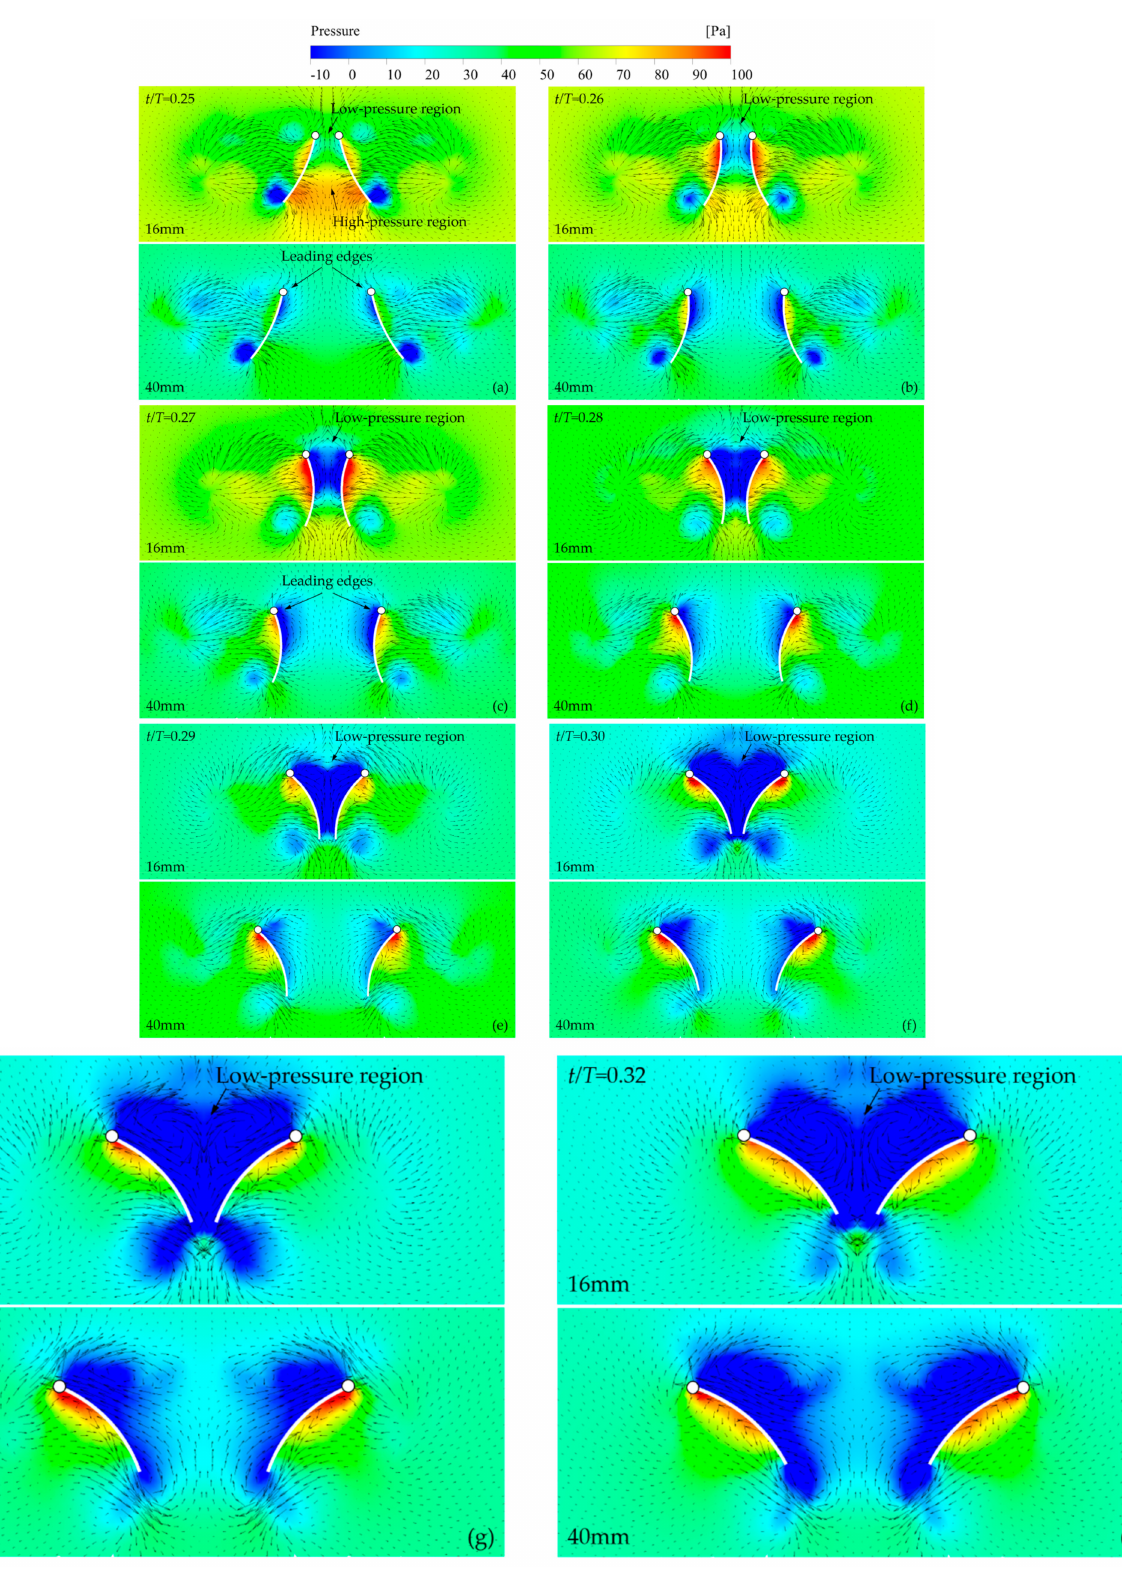
Figure 20. Flow fields in 75%R-plane during up-stroke fling for J = 1. The low pressure region ap-pears firstly near the leading edges ( a – c ), then gradually expands to the whole space between the wings ( d – h ). The leading edges are marked with white